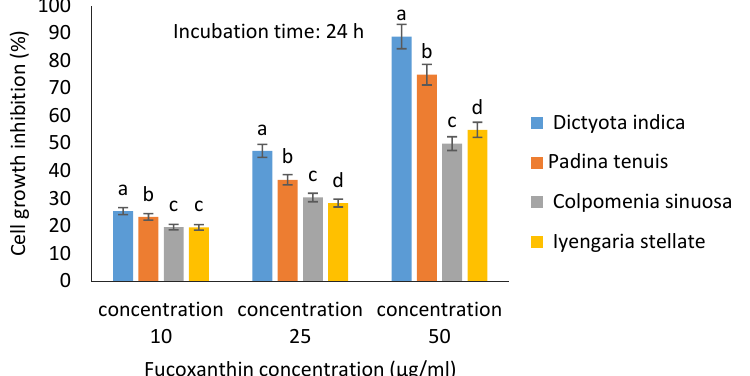
Fig. 3: Percentages of cell growth inhibition at different concentrations of fucoxanthin extract from four species of brown seaweeds (P. tenuis , C. sinuosa , I. stellate and D. Indica) at 24 h incubation time Data are expressed as mean±standared deviation (n=3). Different letters (a, b, c, d) indicate significant mean differences between seaweeds species at a level of p < 0.05